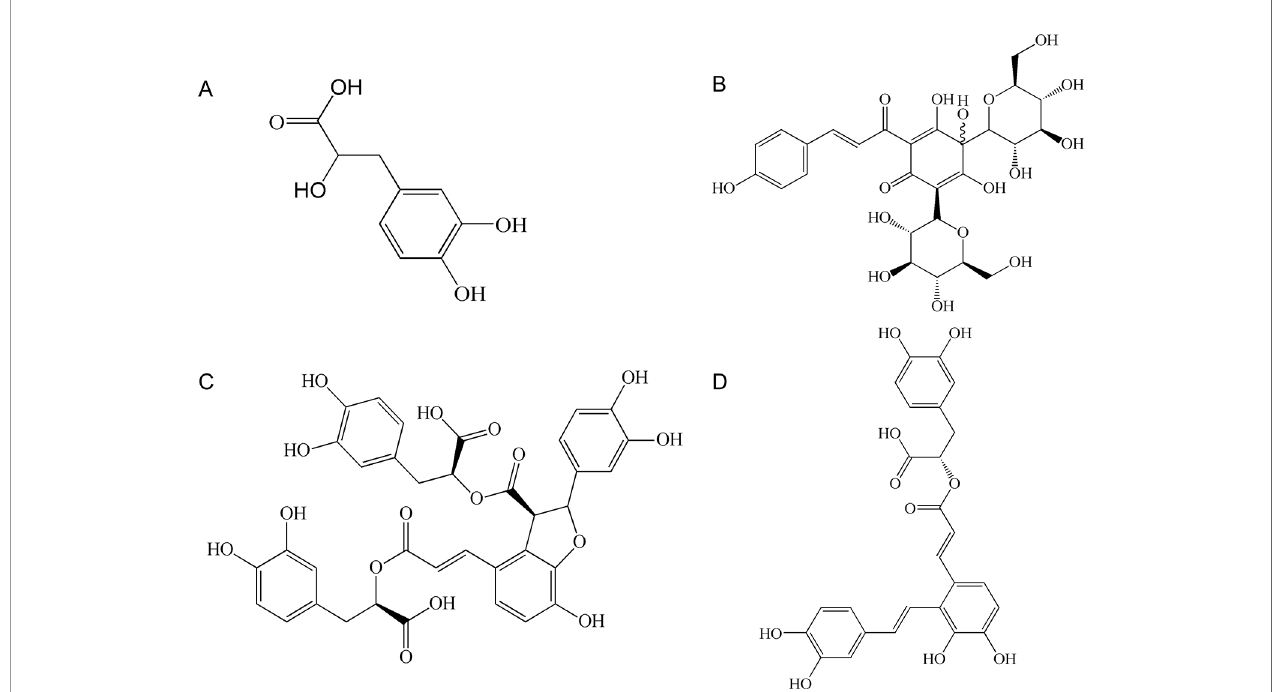
FIGURE 1 | The chemical structure of four components: (A) danshensu (DSS); (B) hydroxysaf fl or yellow A (HSYA); (C) salvianolic acid B (SAB); (D) salvianolic acid A